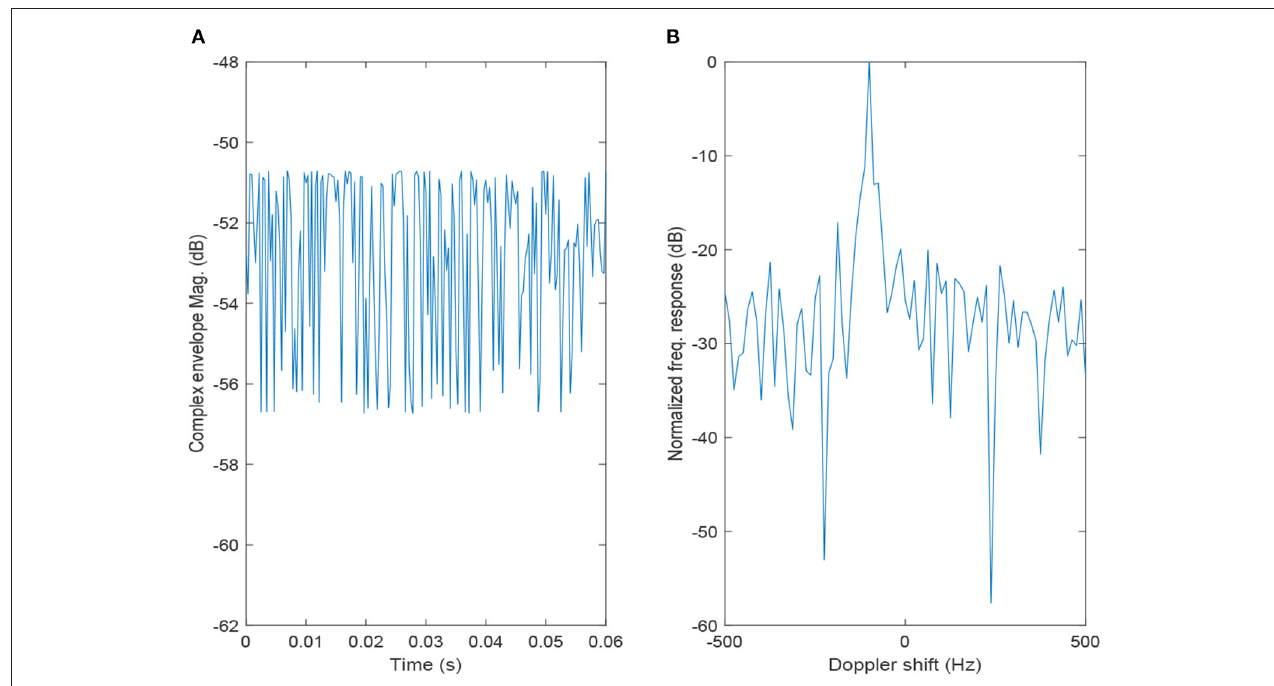
FIGURE 7 | (A) Magnitude of the received signal in the presence of an RIS with random phases, (B) Doppler spectrum of the received signal.